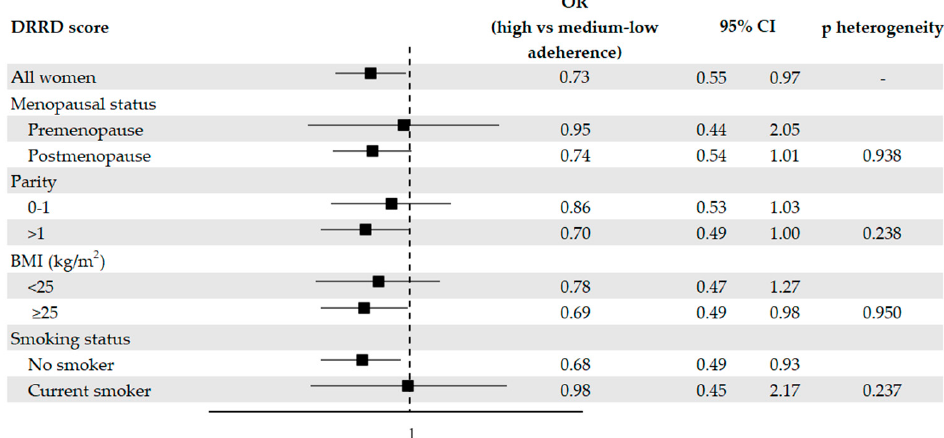
Figure 1. Odds ratios (OR, ) of endometrial cancer for high versus medium–low adherence to the diabetes risk reduction diet (DRRD), with corresponding 95% confidence intervals (CIs), in the overall population and in selected subgroups, Italy, 1992–2006. OR were derived from logistic regression models, conditioned on center and quinquennia of age, and adjusted for years of education, year of interview, body mass index (BMI), occupational physical activity, smoking status, alcohol intake, history of diabetes, total energy intake, age at menarche, parity, menopausal status, use of oral contraceptives, and use of hormone replacement therapy, unless the variable was the stratification factor. P values for heterogeneity were obtained from likelihood ratio tests.